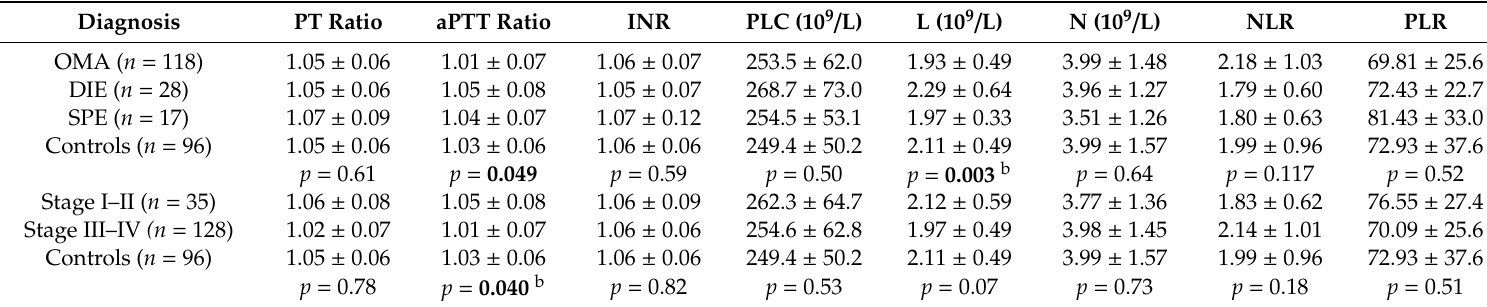
Table 3. Coagulation parameters and systemic inflammatory response markers according to the di ff erent stage and type of endometriosis versus controls, excluding patients taking hormonal